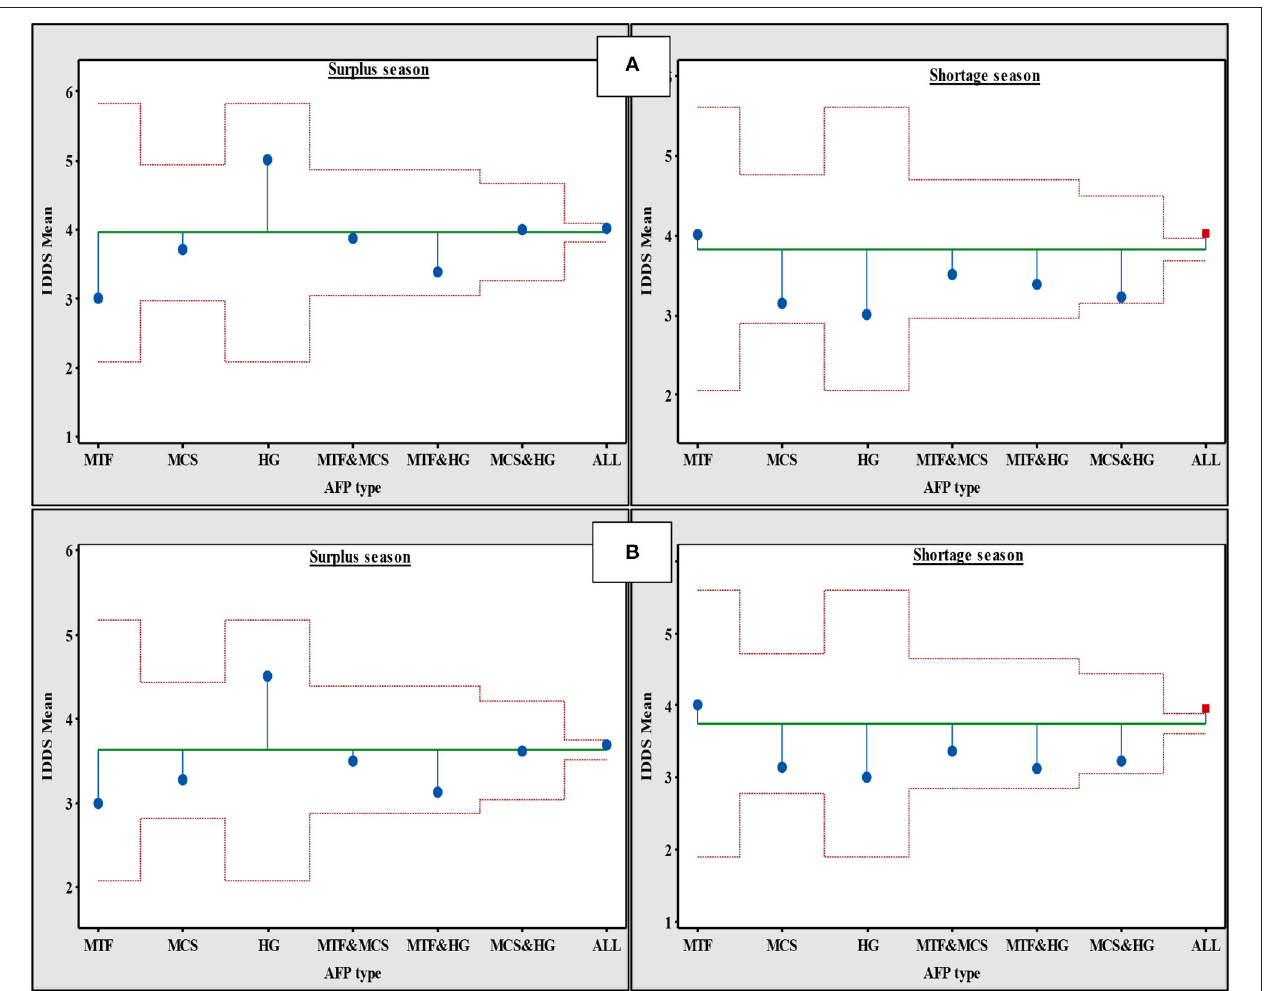
FIGURE 3 | One-way ANOM of IDDS across seven AFP combinations by sensitive groups in two seasons ( α (B) Women of reproductive age. HG, homegarden; MCS, multi-story coffee system; MTF, multipurpose tree on farmland; IDDS, individual dietary diversity